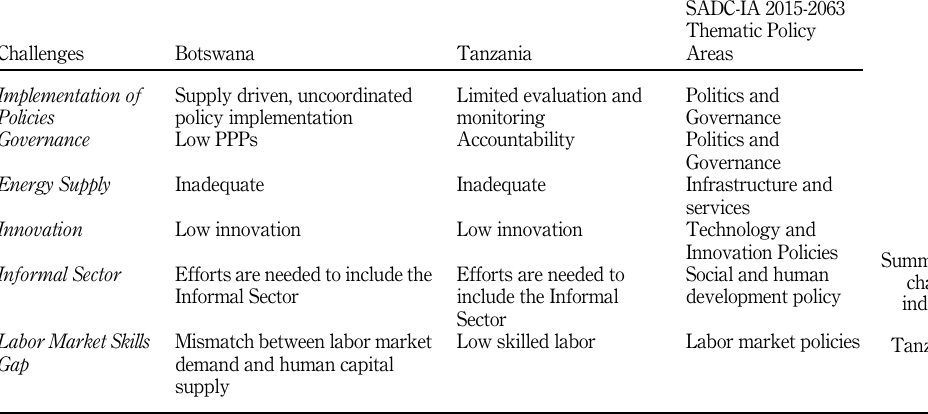
Table 4. Summary of identified challenges towards industrialization for Botswana and Tanzania and